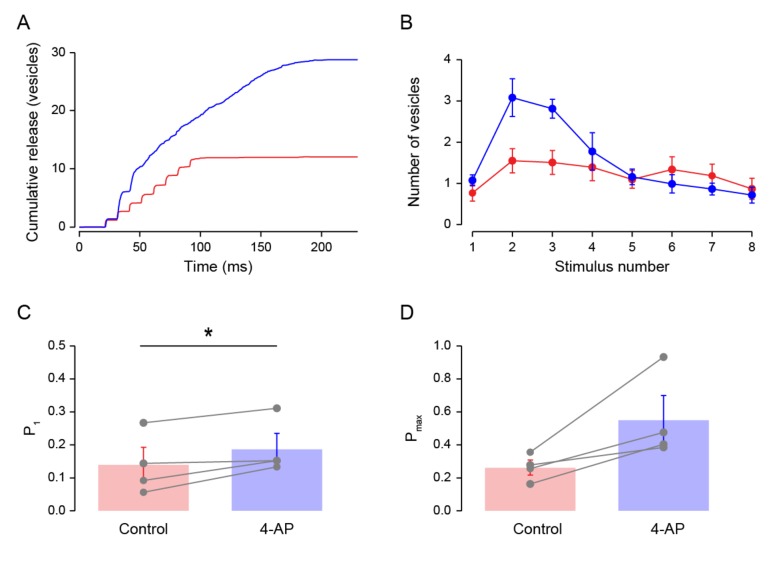
Effect of 4-AP on release.In these experiments, simple synapses were recorded first in 1.5 mM [Ca2+]o and 1 mM TEA. SV counts were compared under this starting condition and >5 min after addition of 15 μM of 4-aminopyridine (4-AP), a broad spectrum blocker of voltage-dependent K+ channels. (A) An example of cumulative vesicle counts during a train of 8 stimuli evoked at 100 Hz in control condition (red) and after addition of 4-AP (blue). (B) Average number of released vesicles as a function of stimulus number in control and after 4-AP. (C) 4-AP increased the release probability for the 1st stimulus (ppt = 0.049). (D) 4-AP did not significantly increase the maximal release probability (ppt = 0.067).